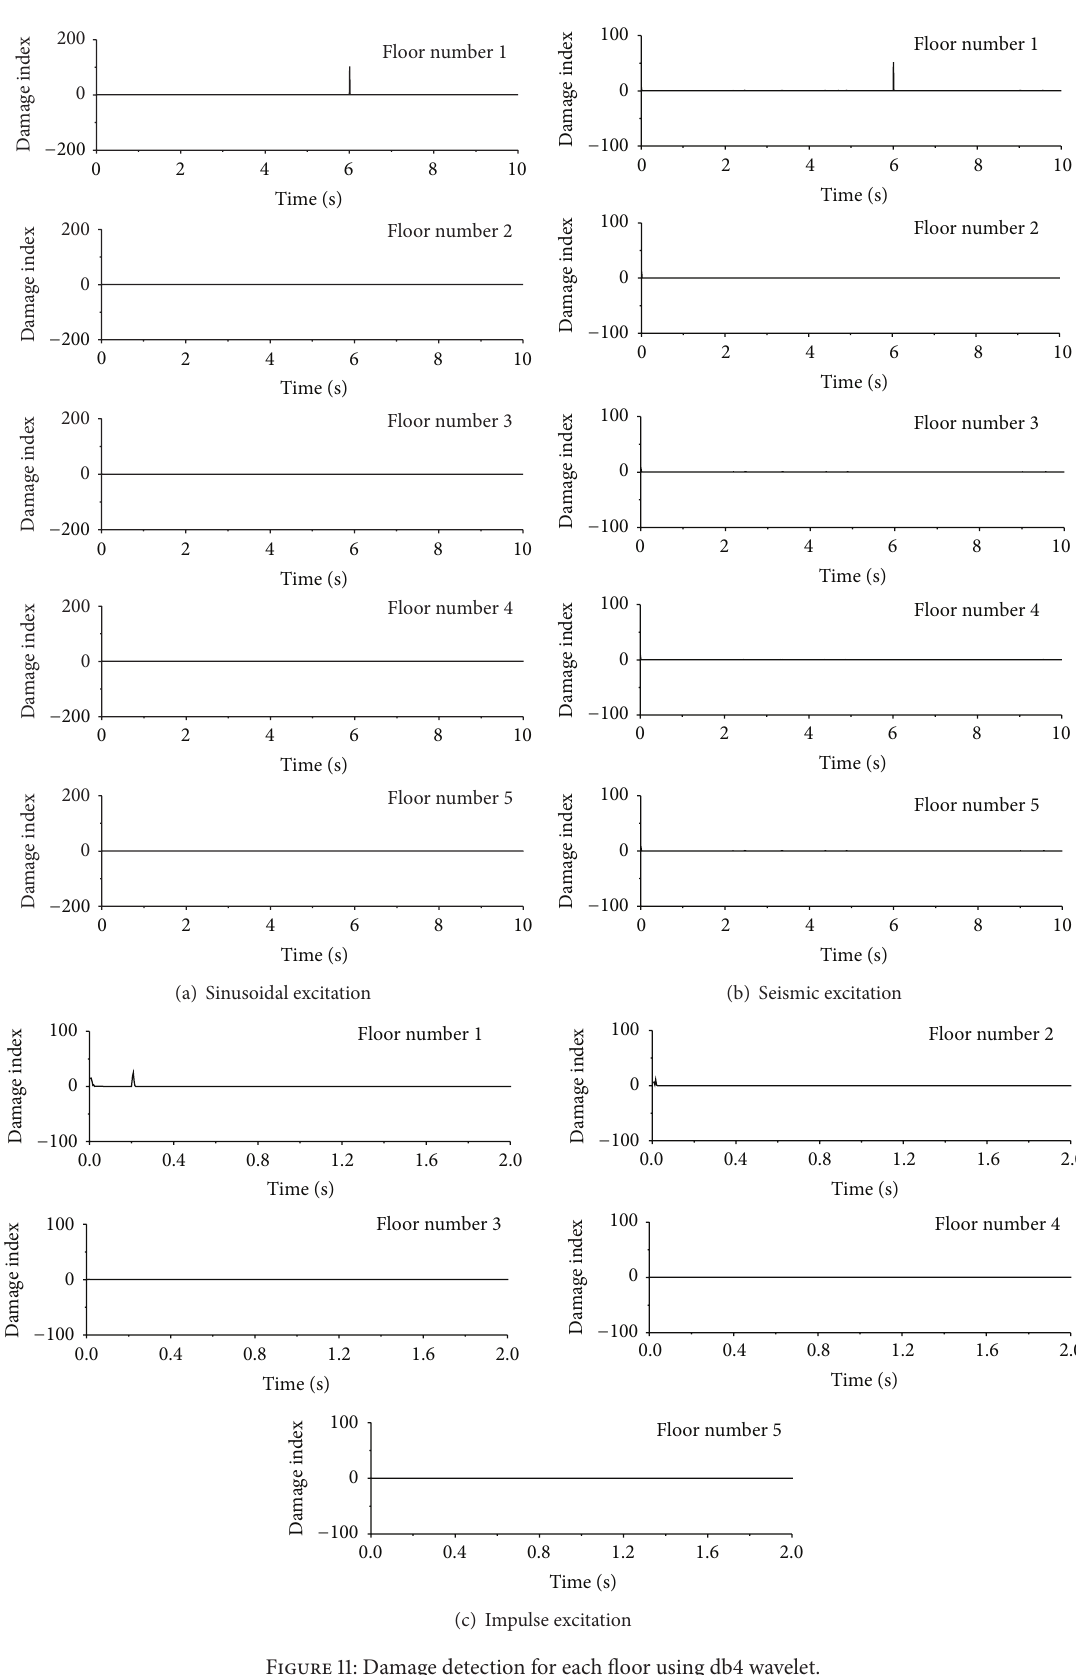
Figure 11: Damage detection for each floor using db4